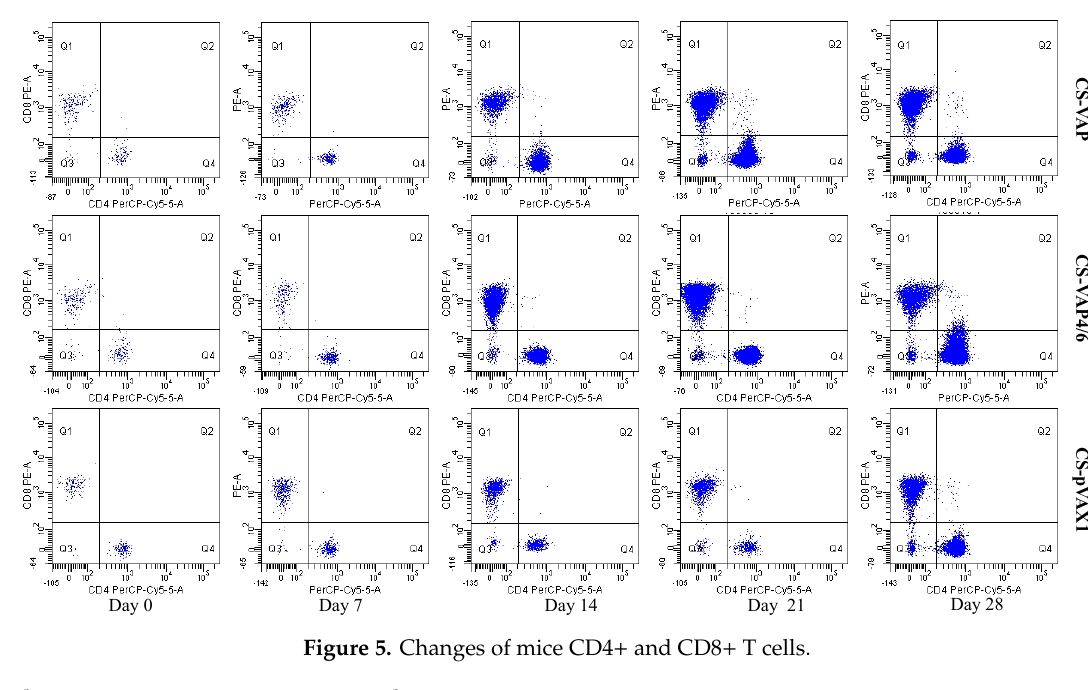
Figure 5. Changes of mice CD4+ and CD8+ T cells.